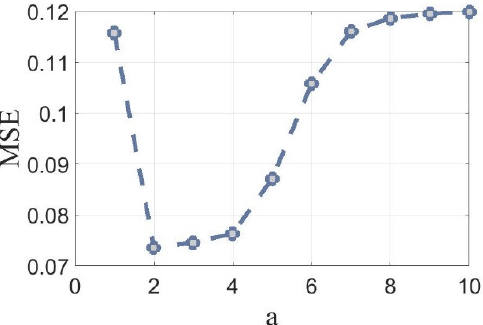
Figure 6. Mean square error (MSE) of binarization and ground truth segmentation for different a value.